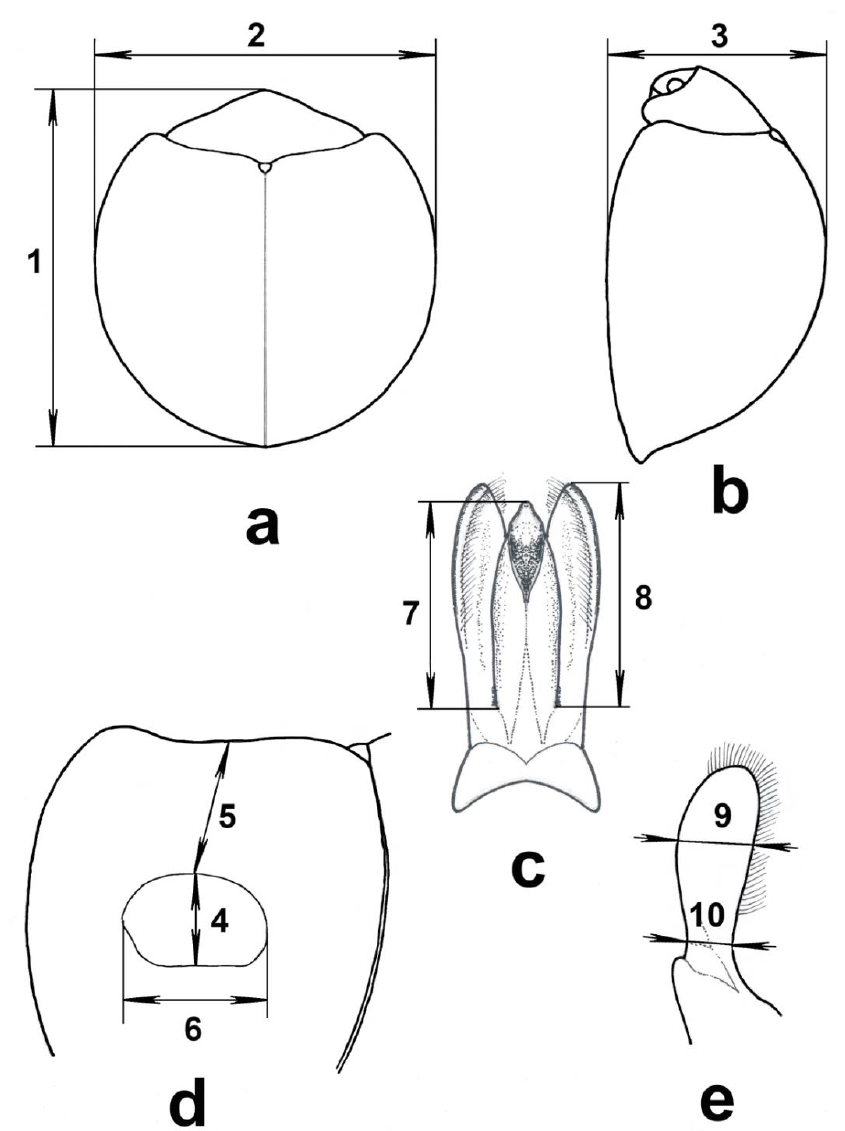
Figure 1. Examined morphological details. ( a ) General dorsal view; ( b ) general lateral view; ( c ) male penis guide and parameres, ventral view; ( d ) left elytron, dorsal view; ( e ) male paramere, lateral view. Measured characteristics: 1 — body length, 2 — body width, 3 — body height, 4 — length of the elytral marking along midline in the plane of the marking, 5 — distance from the elytral marking to the base of elytron in the plane of elytron, 6 — maximal width of the elytral marking in the plane of the marking, 7 — length of penis guide from the junction with paramere to the apex, 8 — length of paramere from the junction with the penis guide to the apex, 9 — maximal width of paramere, 10 — width of paramere at the constriction near the base.